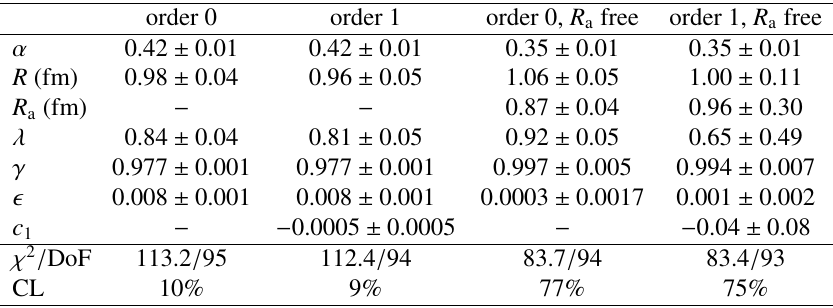
Table 2. Fit results of τ -model parametrizations for three-jet